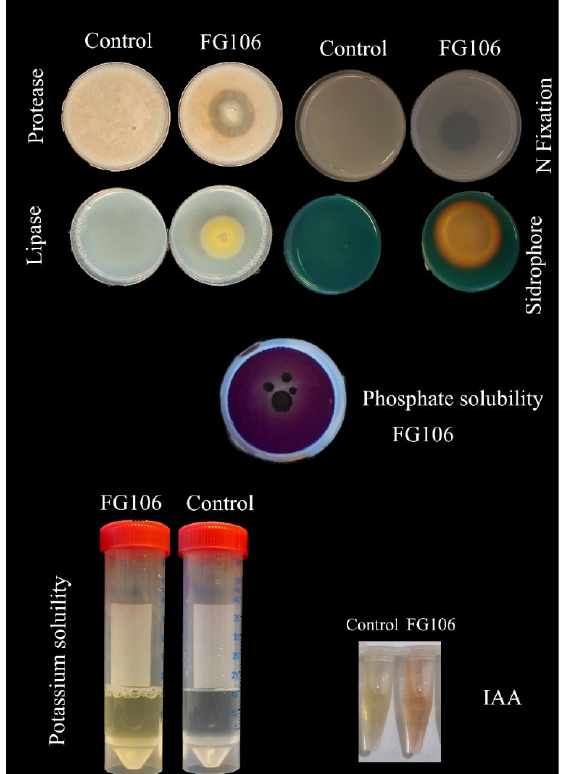
Figure 3. Hydrolytic enzyme activity and growth promotion factor production by the FG106 strain in experiments targeting protease and lipase production, nitrogen fixation, siderophore production, phosphate solubilization, potassium solubilization, and IAA production.